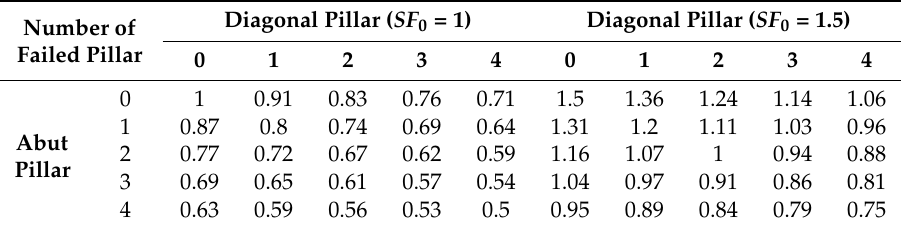
Table 5. The safety factor for a pillar after its neighboring pillars